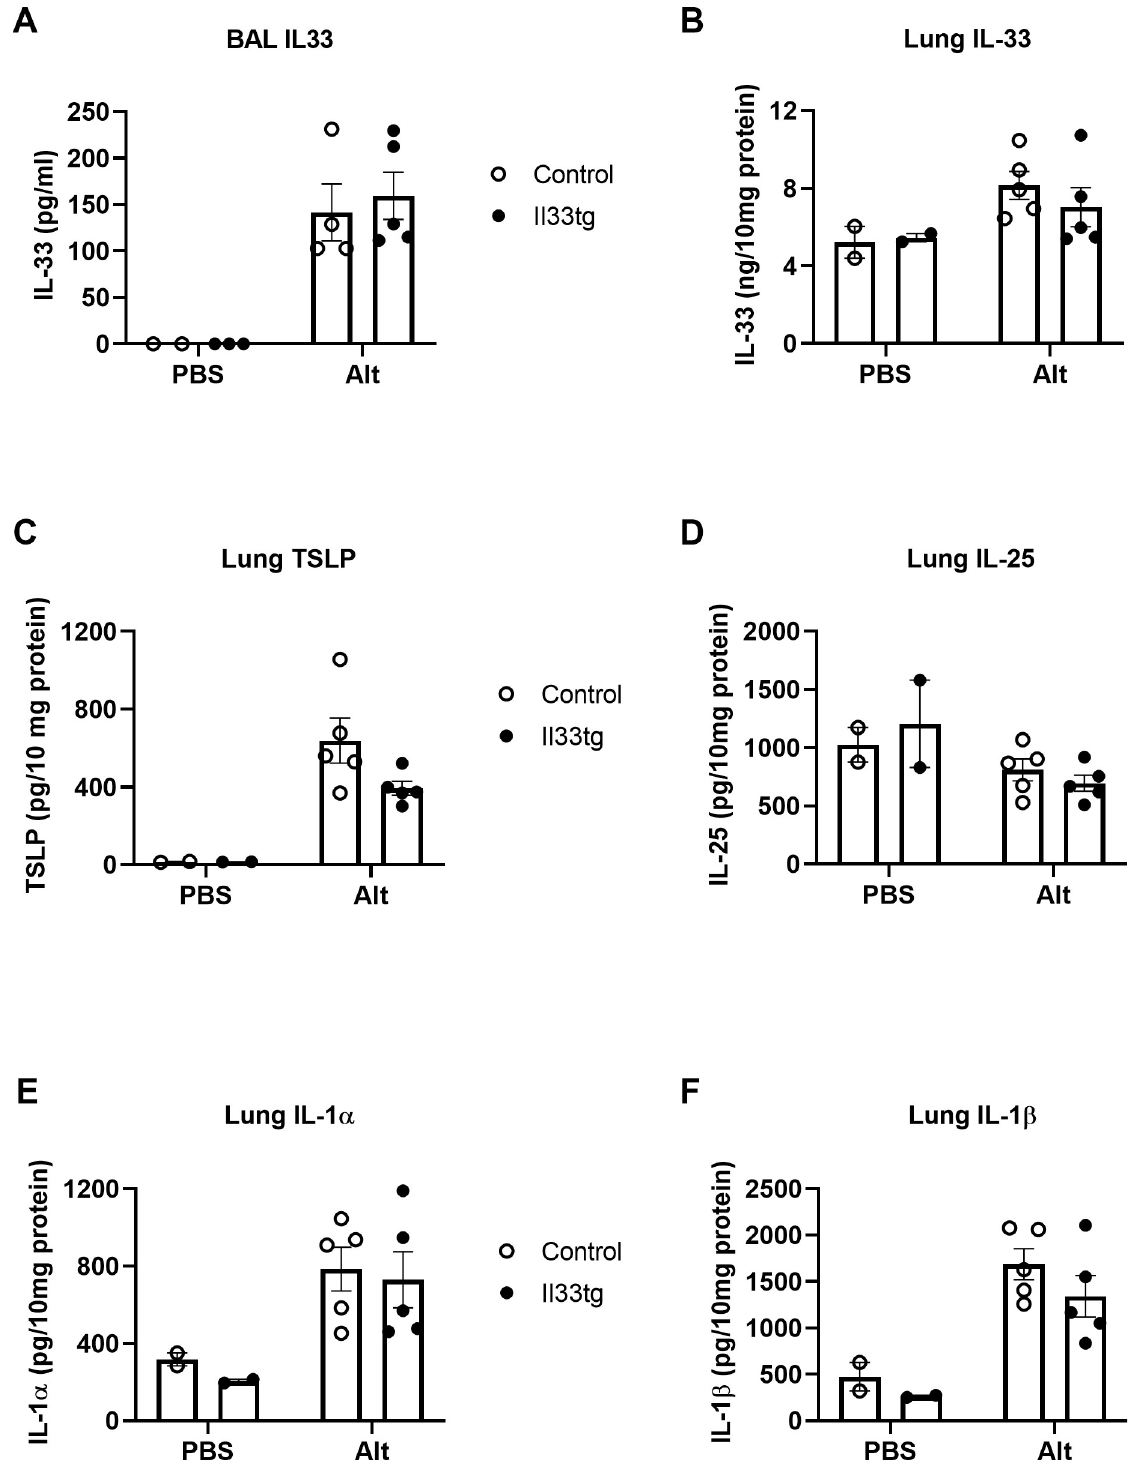
Fig 3. Alt extract induced comparable levels of IL-33 airway lumen release and lung epithelial cytokine production in neonatal- IL-33-experienced mice and control mice. Mice were provided with Dox water on postnatal days 6–13. After resting for 4–6 weeks, the mice were i.n. exposed to Alt extract (50 μ g/mouse). BAL IL-33 (A) was analyzed at 1 hour post Alt exposure. Lung cytokines (B-F) were analyzed at 4.5 hours post Alt exposure. Data are presented as means + SEMs (n = 2 mice per group for PBS exposure; n = 4–5 mice per group for Alt exposure). Data are representative of two independent